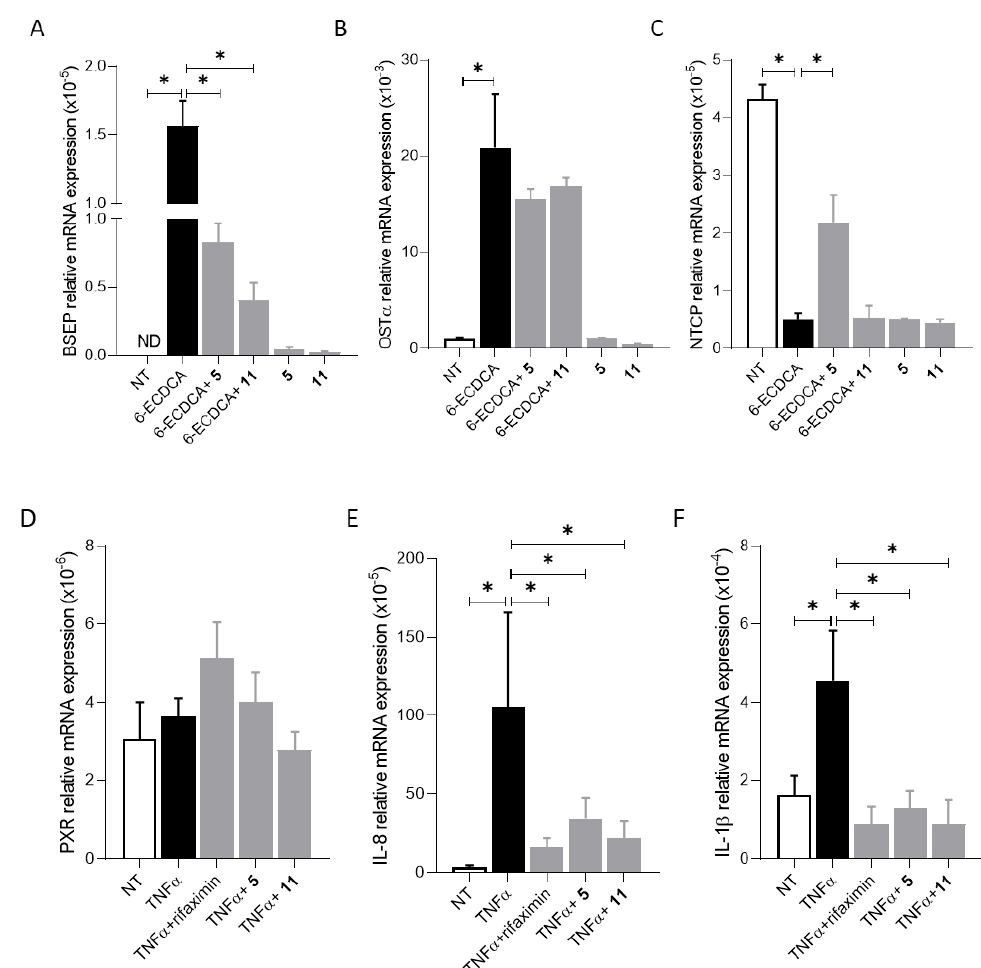
Figure 2. Panels ( A – C ) Effects of compounds 5 and 11 on the relative mRNA expression of FXR genes in HepG2 cells left untreated, treated with 6-ECDCA (10 µ M), compounds 5 or 11 (10 µ M), or a combination of 6-ECDCA plus 5 or 11 . Results are expressed as mean ± SEM. ( D – F ) Effects of compounds 5 and 11 on the relative expression of PXR and inflammatory cytokines in Human-CaCo2 cells left untreated, treated with TNF α (100 ng/mL) alone, or in combination with 5 or 11 (10 µ M). Results are expressed as mean ± SEM. * p < 0.05 versus not treated cells